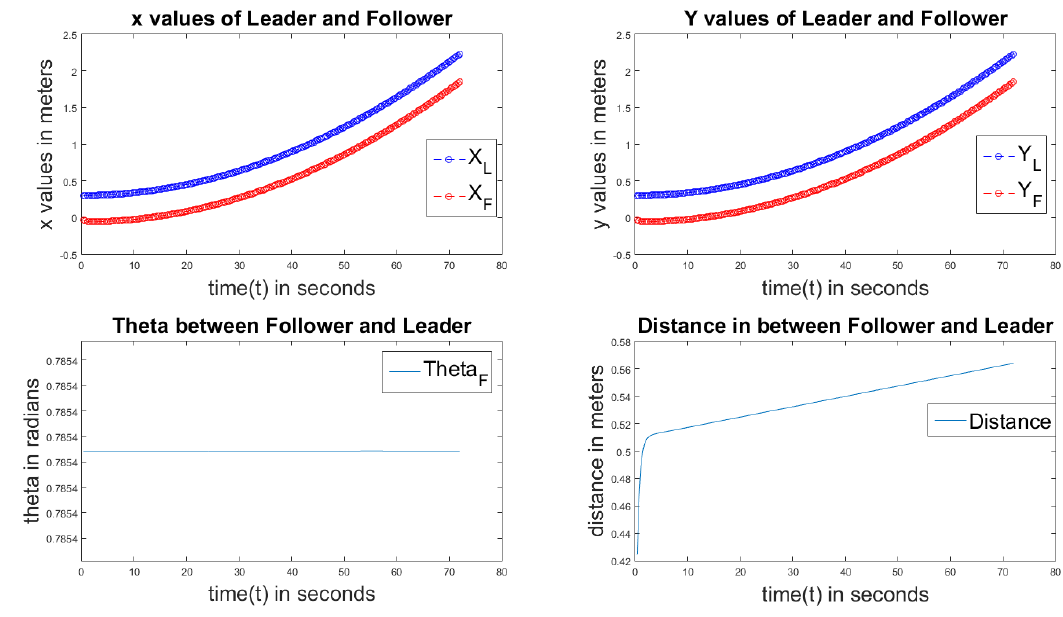
Figure 9. P controller of a line.